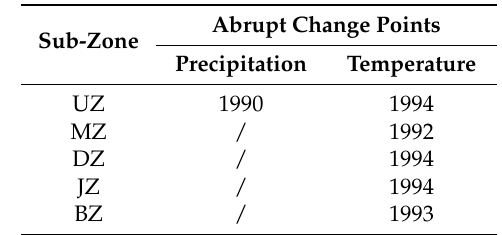
Table 3. Abrupt changes in the meteorological series from 1960 to 2010.